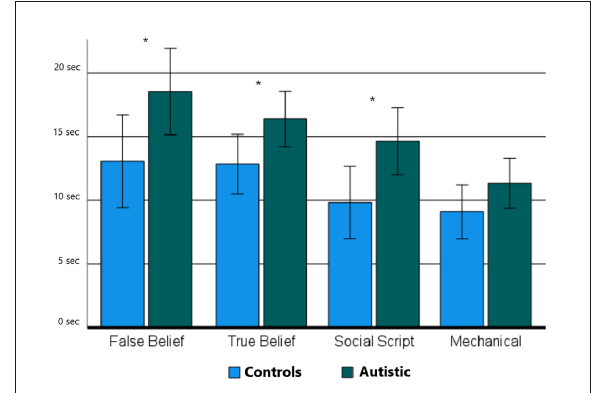
FIGURE2 The mean response times until the first response is given per sequence Type (False Belief, True Belief, Social Script, and Mechanical) and Group (Neurotypical Controls and Autistic). Asterisks indicate significant differences between groups as demonstrated using a one-sided independent sample t-test with * p <